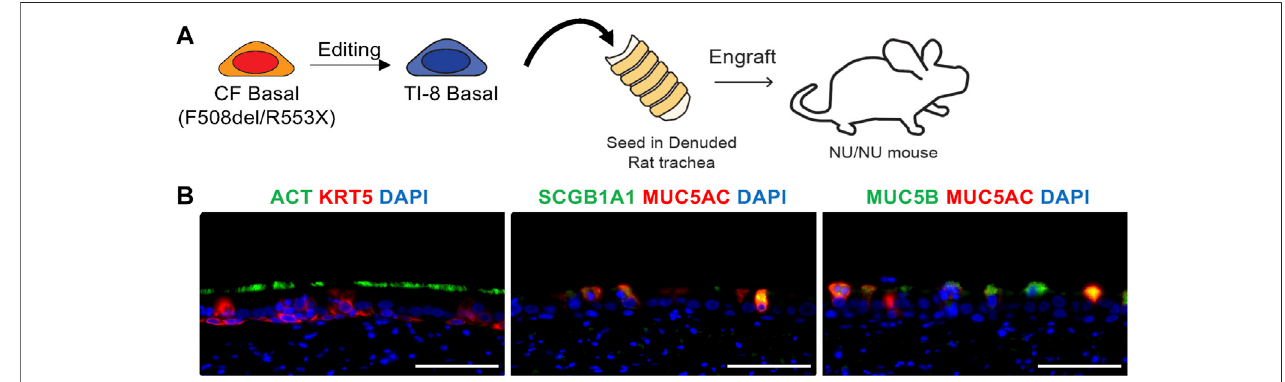
FIGURE 1 | In vivo engraftment ofedited basal cells (BCs) in tracheal xenografts. (A) Schematic of tracheal xenograft. Bulk TI-8 F508del/R553X BCs were seeded in denuded trachea and implanted into the fl ank of a Nu/Nu mouse. (B) Identi fi cation of basal (KRT5), secretory (SCGB1A1, MUC5AC, MUC5B), and multiciliated (ACT) cells using immunostaining. DAPI staining indicates DNA (Scale bar = 50 μ